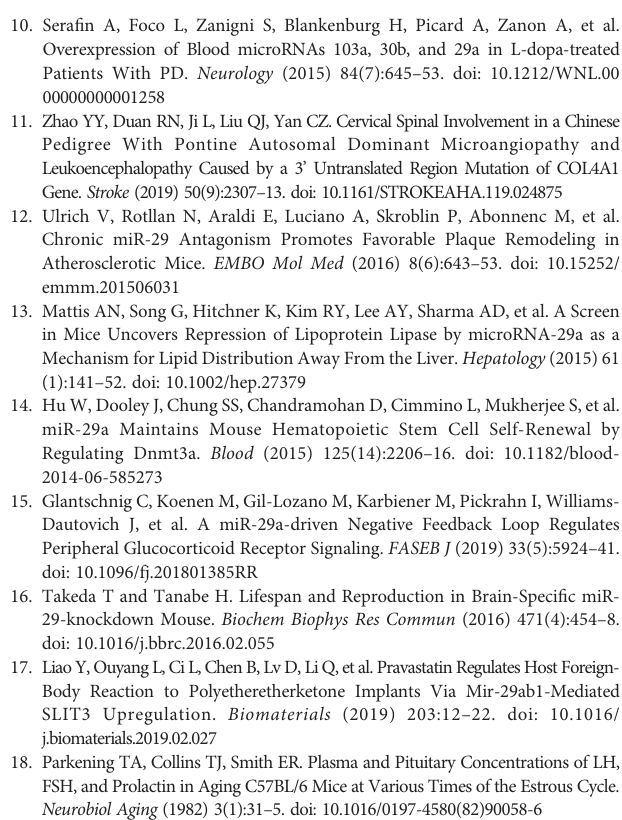
Supplementary Table 1 | List of oligonucleotides used. Supplementary Figure 1 | Genotyping of miR-29a/b 1 KO knockout mice. (A) The genotype of miR-29a/b 1 KO was identi fi ed by PCR ampli fi cation. There was 600bp deleted from the genomic DNA of miR-29a/b 1 . +/+: wild-type, +/-: heterozygous, -/-: homozygous. (B) Mature miR-29a RNA was detected in different tissues of wild-type mice but not in those of homozygous knockout mice (n=3). The precursor of miR-29a (C) and miR-29b 1 (D) RNA level was measured by